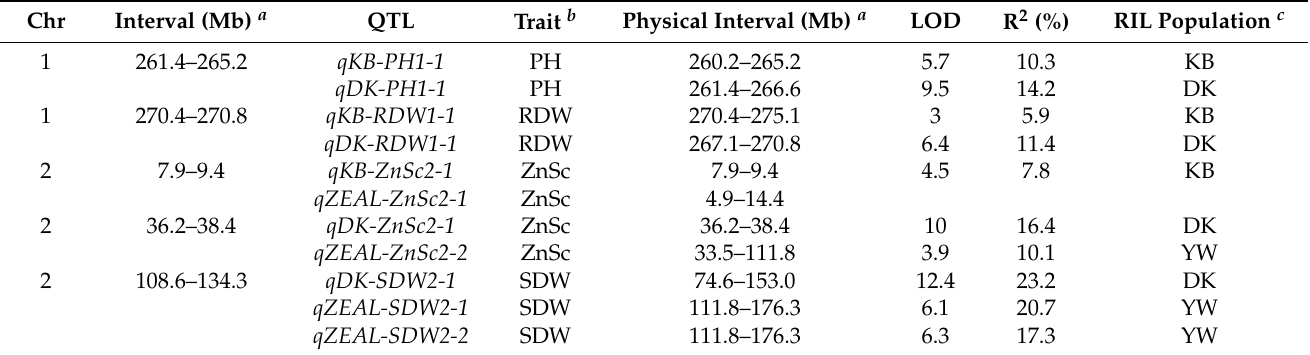
Table 3. QTLs colocalized with the loci controlling different traits in the K22 × BY815, DAN340 × K22, and Ye478 × Wu312 RIL populations.